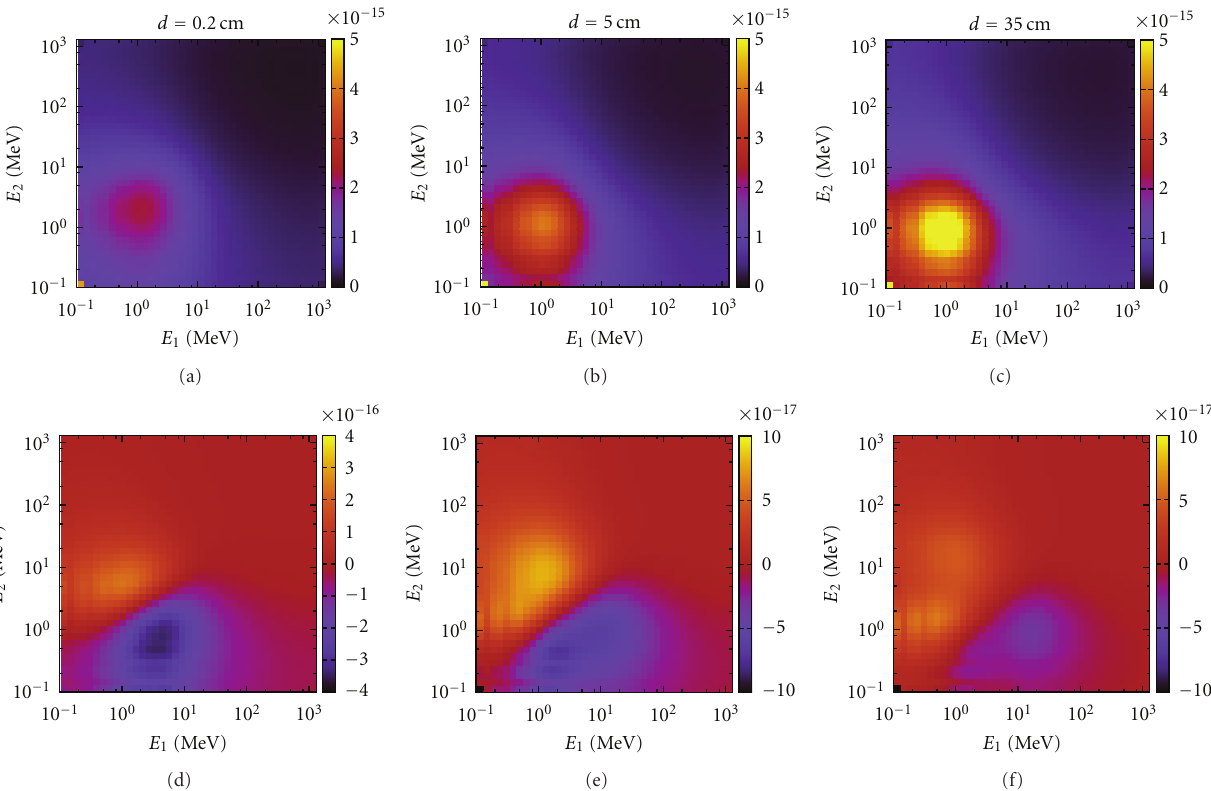
Figure 11: Two-particle neutron spectra χ ( E 1 , E 2 ) (a)–(c) and neutron spectrum covariance functions C χ ( E 1 , E 2 ), (d)–(f) for di ff erent target thicknesses d